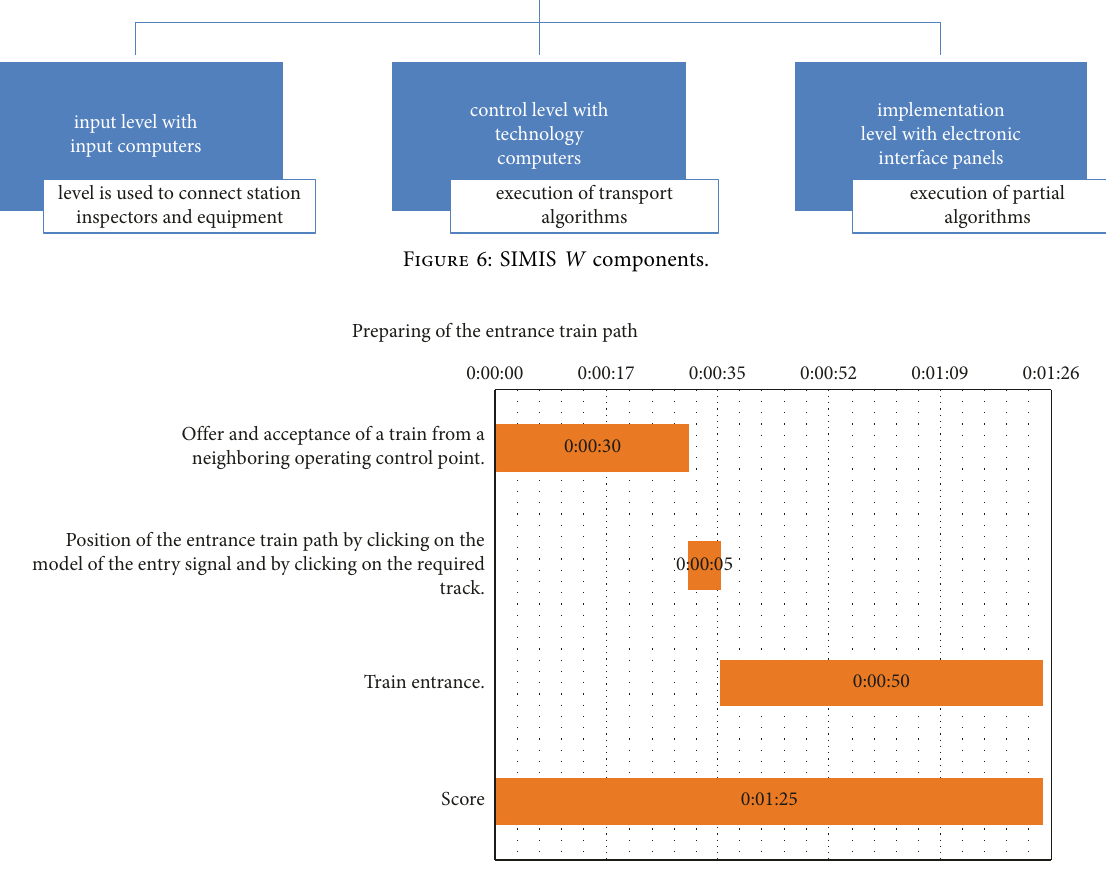
Figure 7: Preparing the entrance train path on the electronic signal box.